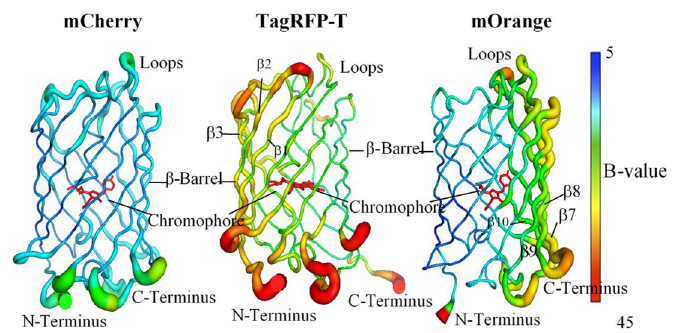
Figure 1. Structures of mCherry (2H5Q.pdb), TagRFP-T (5JVA.pdb), and mOrange (2H5O.pdb). Note that mOrange is shown as the crystal structure of mOrange2 has not been reported yet. The width and color of the ribbon in the figure show the relative atomic B-factor distribution normalized to the overall averaged B-factor value.